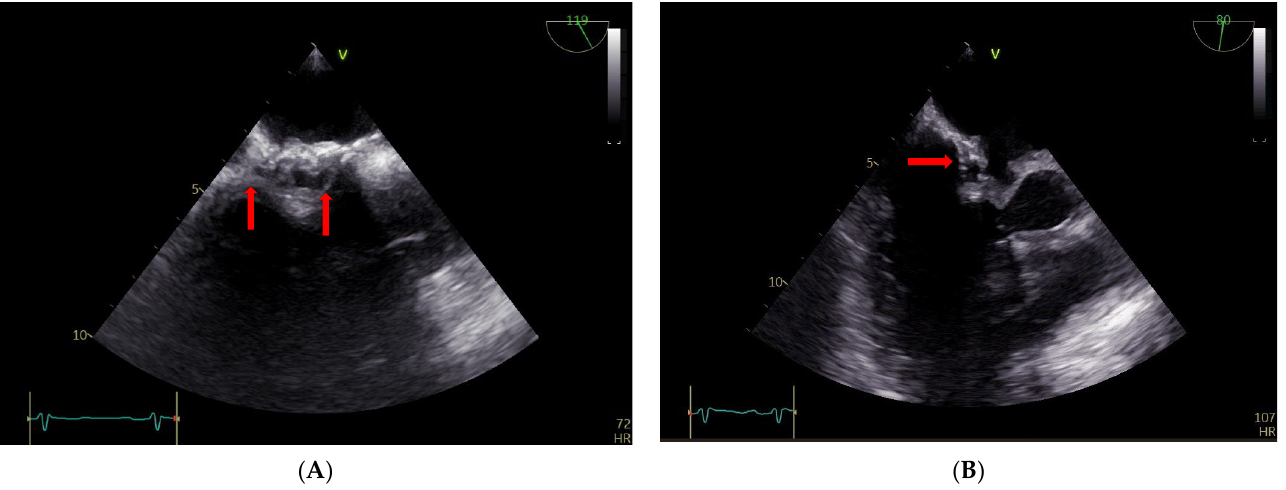
Figure 4. ( A , B ) TEE: abscess on the right side of the atrial surgical patch with ecolucent spaces (arrows).